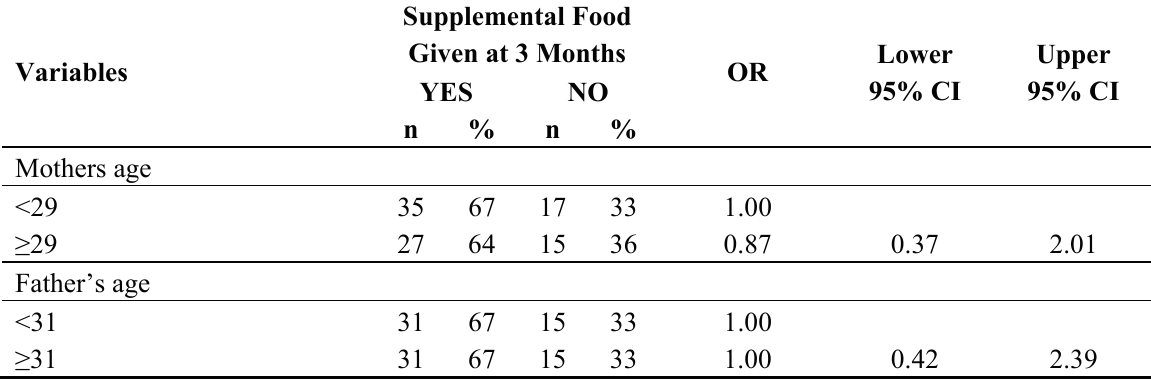
Table 4. Factors influencing the likelihood of a mother giving supplementary food at 3 months